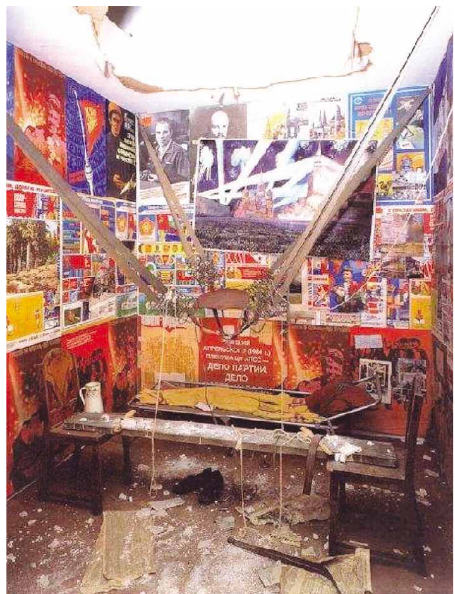
Fig. 1. Ilya Kabakov. The Man Who Flew Into Space From His Apartment ,